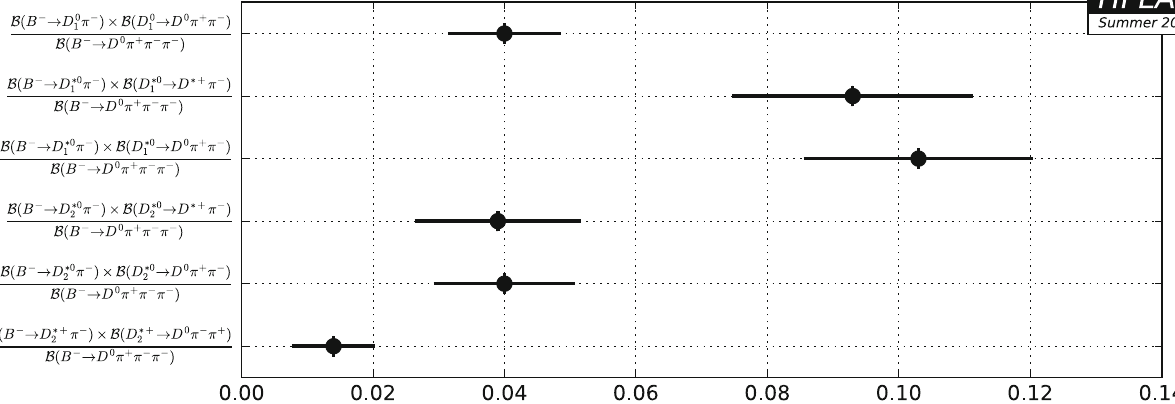
Fig. 114 Summary of the averages from Table 144